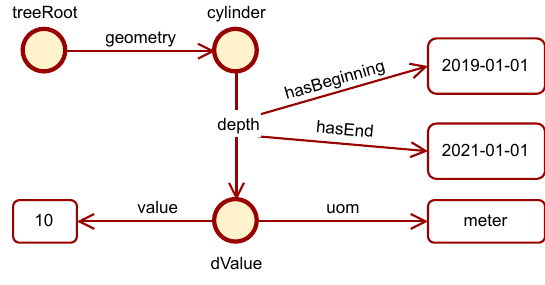
Figure 3. Representation of the temporal validity of a cylinder’s